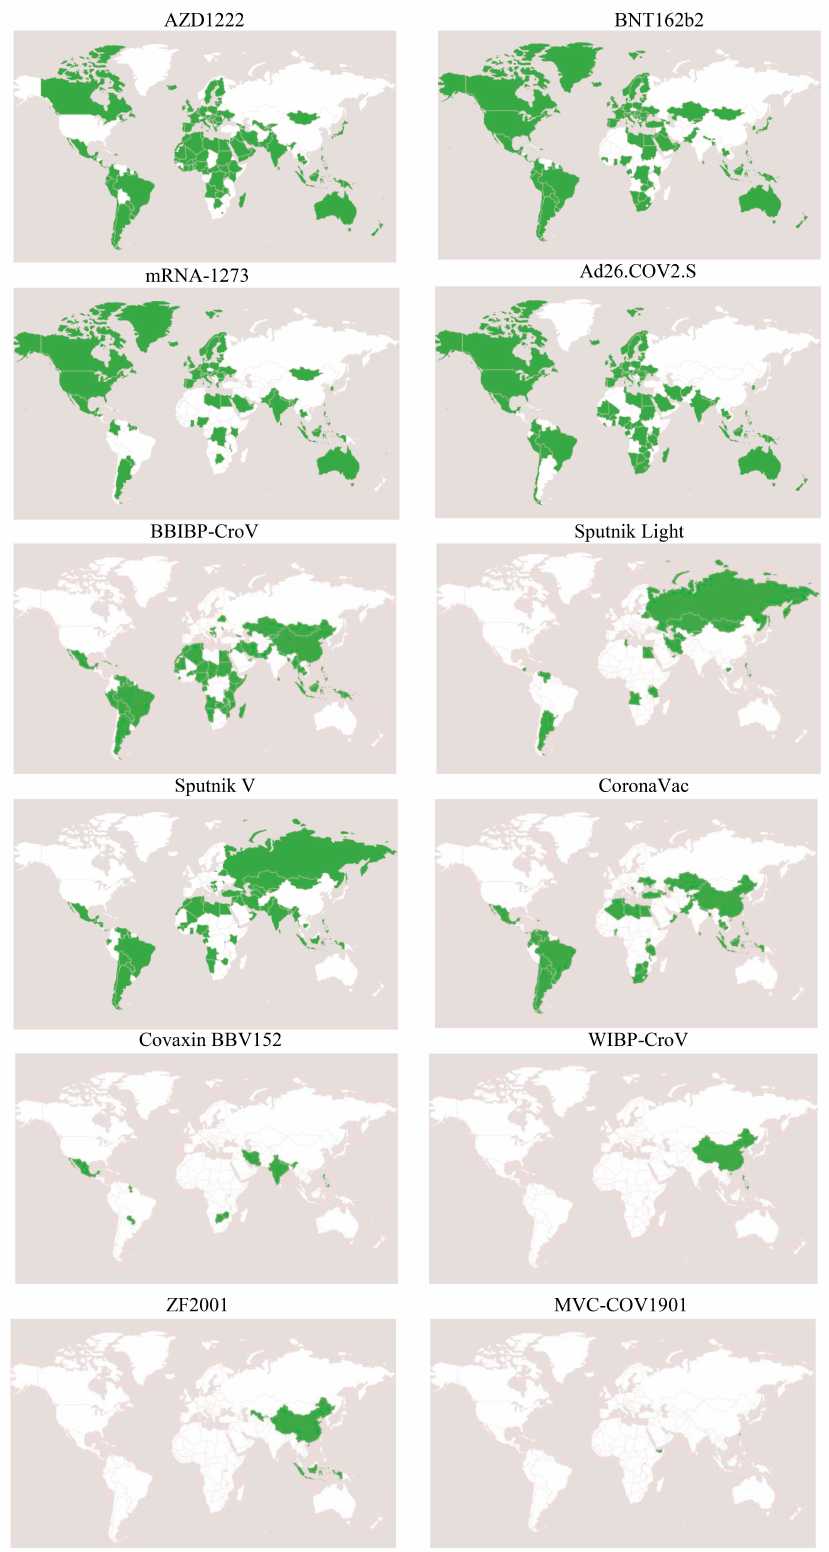
Figure A1. Four vaccines of AZD1222 (Oxford-AstraZeneca), BNT162b2 (Pfizer-BioNTech), Ad26.COV2.S (Johnson and Johnson), and mRNA-1273 (Moderna) have been injected by more countries. In total, these vaccines were licensed for use in 134, 132, 101, and 85 countries,